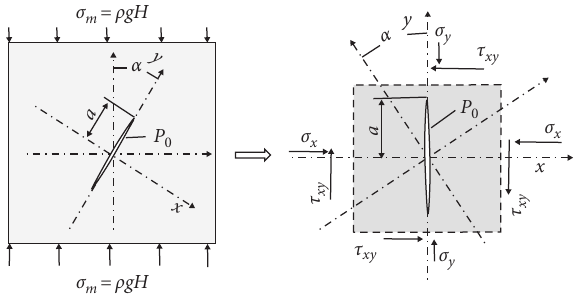
Figure 2: Stress state of cracks in front of the working